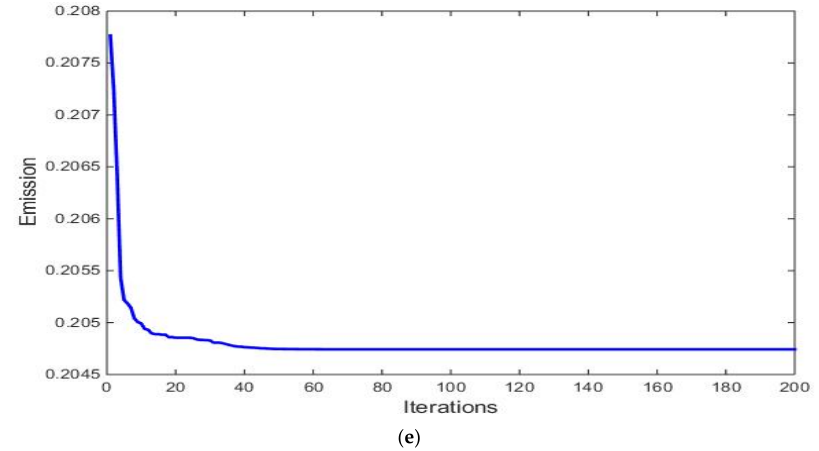
Figure 1. Convergence rate for single objective cases (Cases 1 – 5). ( a ) fuel cost minimization (Case 1), ( b ) voltage deviation minimization (Case 2), ( c ) Voltage stability (Case 3), ( d ) Power losses (Case 4), ( e ) Emission minimization (Case 5).